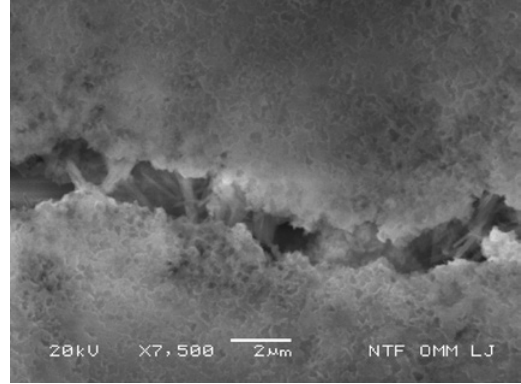
Table 2 Results of the laboratory analysis for fly ash.